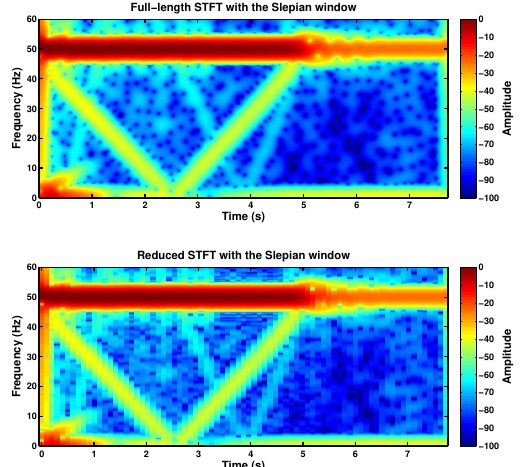
Figure 16. TF distribution of the stator current of the faulty machine presented in Section 4, using the full length TF analysis with a Slepian window (154.65 s, 186608 kB) ( top ) and using the proposed reduced length TF analysis with the truncated Slepian window (0.59 s, 59 kB) ( bottom ). 5.1. Comparison between the Spectrograms Generated with the Truncated Gaussian Window and with the Truncated Slepian Window